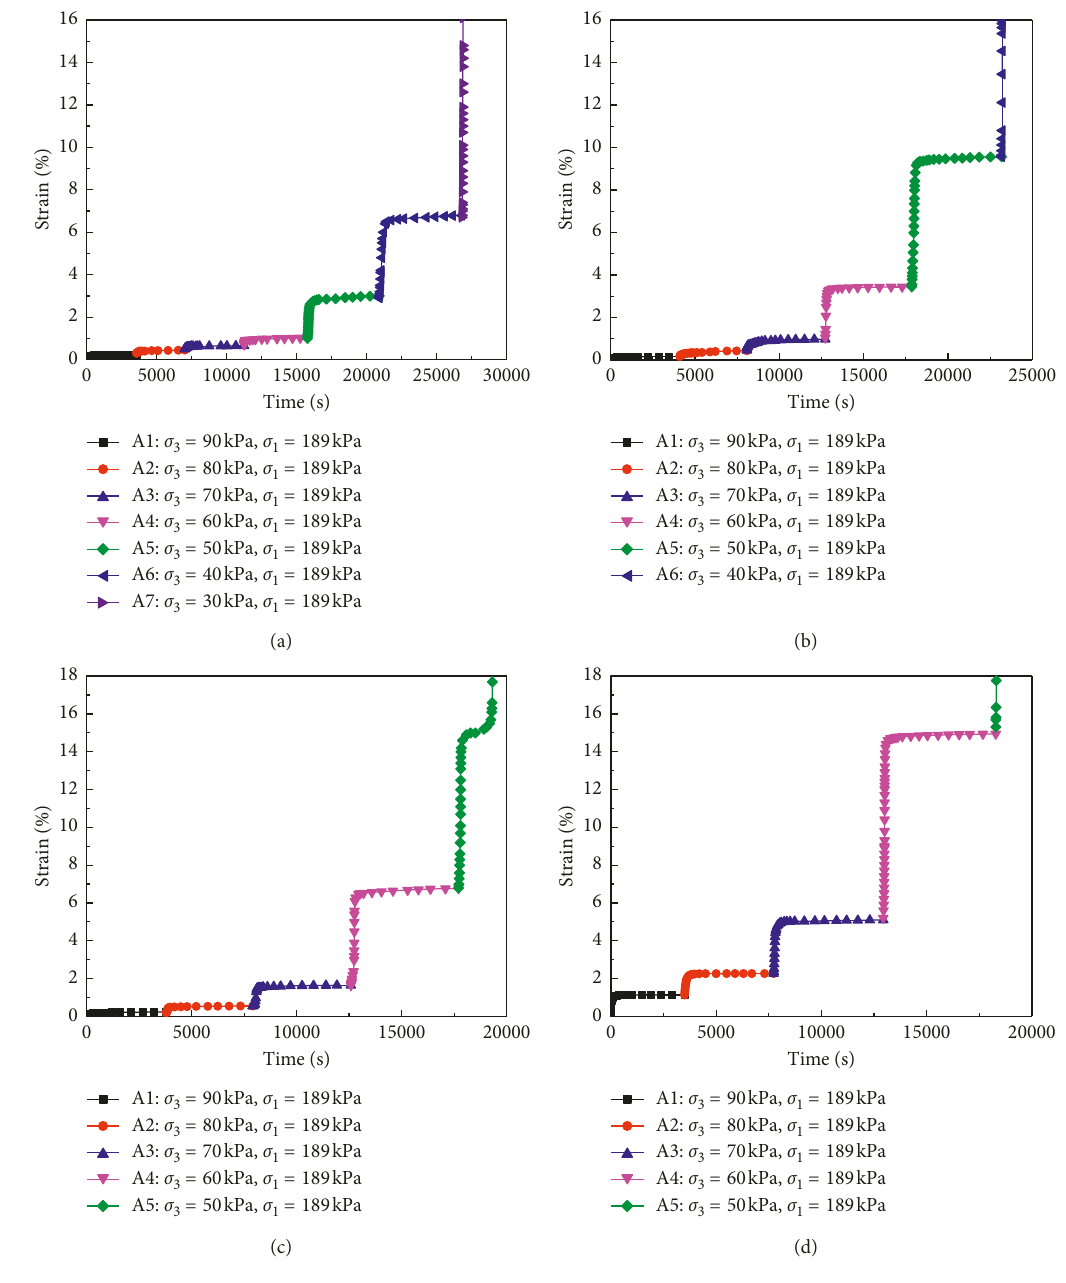
Figure 2: The unloading strain-time curves of soft soil under different initial excess pore water pressures (consolidation confining pressure 100kPa). (a) Excess pore water pressure u 0 (d) Excess pore water pressure u 0